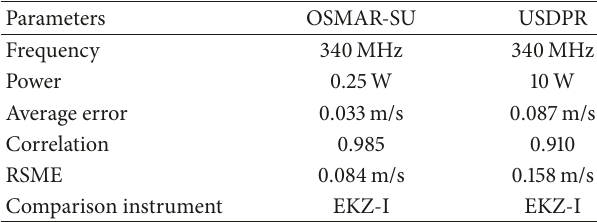
Table 3: Comparisons between OSMAR-SU and